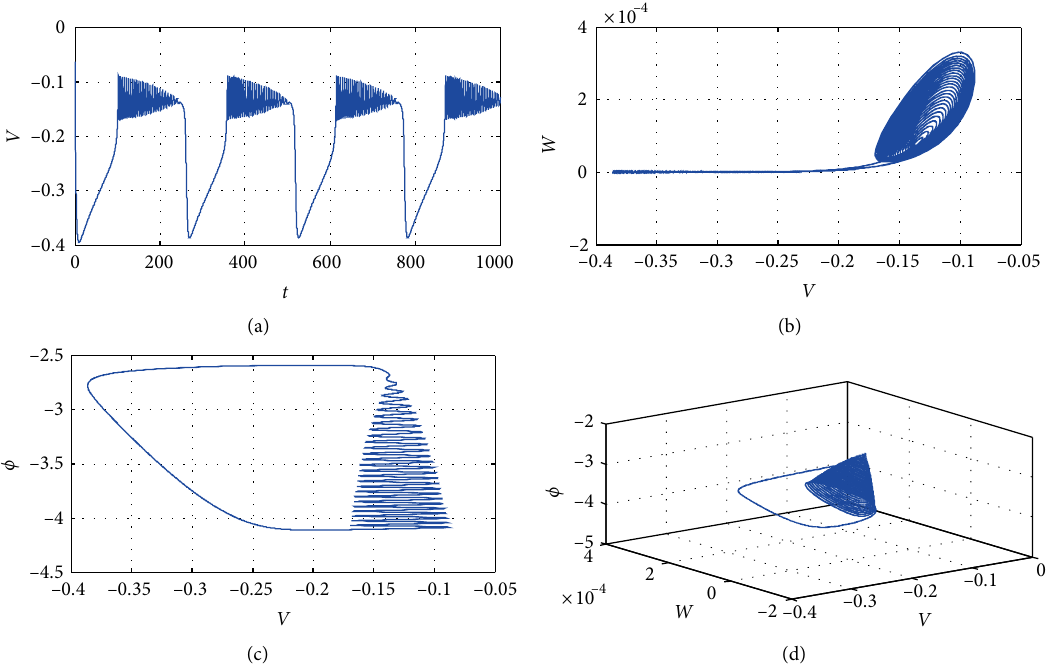
Figure 7: Sampled time series for membrane potential and phase diagrams when the system parameters are selected as 𝐼 = 0 , 𝑘 𝑘 2 = 0.15 , 𝑘 3 = 0.15 , and 𝑉 𝐾 = −300